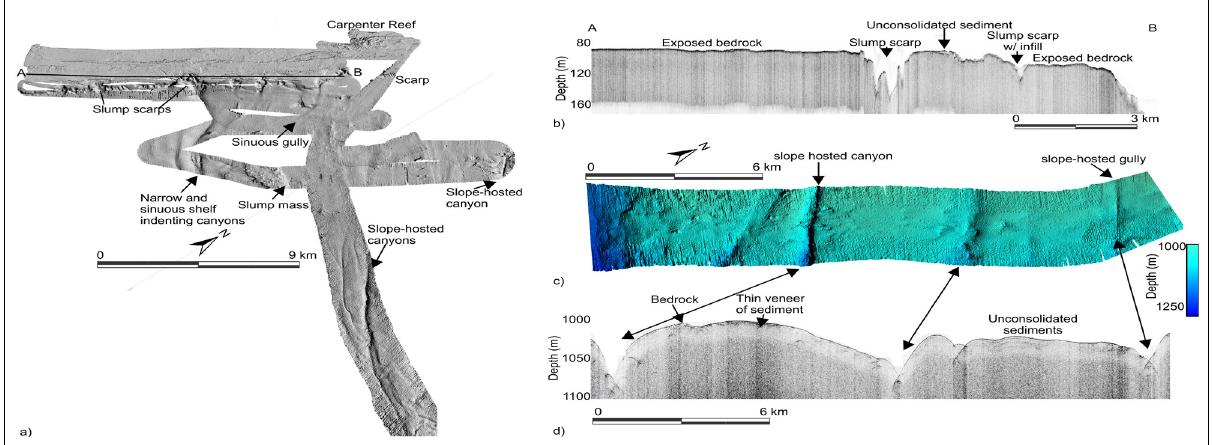
Figure 4: An example of a shelf edge-mass wasting complex. (a) 3D multibeam bathymetry view looking upslope of a series of slumps merging with sinuous gullies and slope-hosted canyons. (b) Seismic reflection profile detailing the hard bedrock of the shelf edge into which the slumps have incised. (c) Multibeam bathymetry showing deeper slope-hosted canyons and gullies. (d) Seismic reflection profile highlighting the interfluves of slope-hosted canyons.